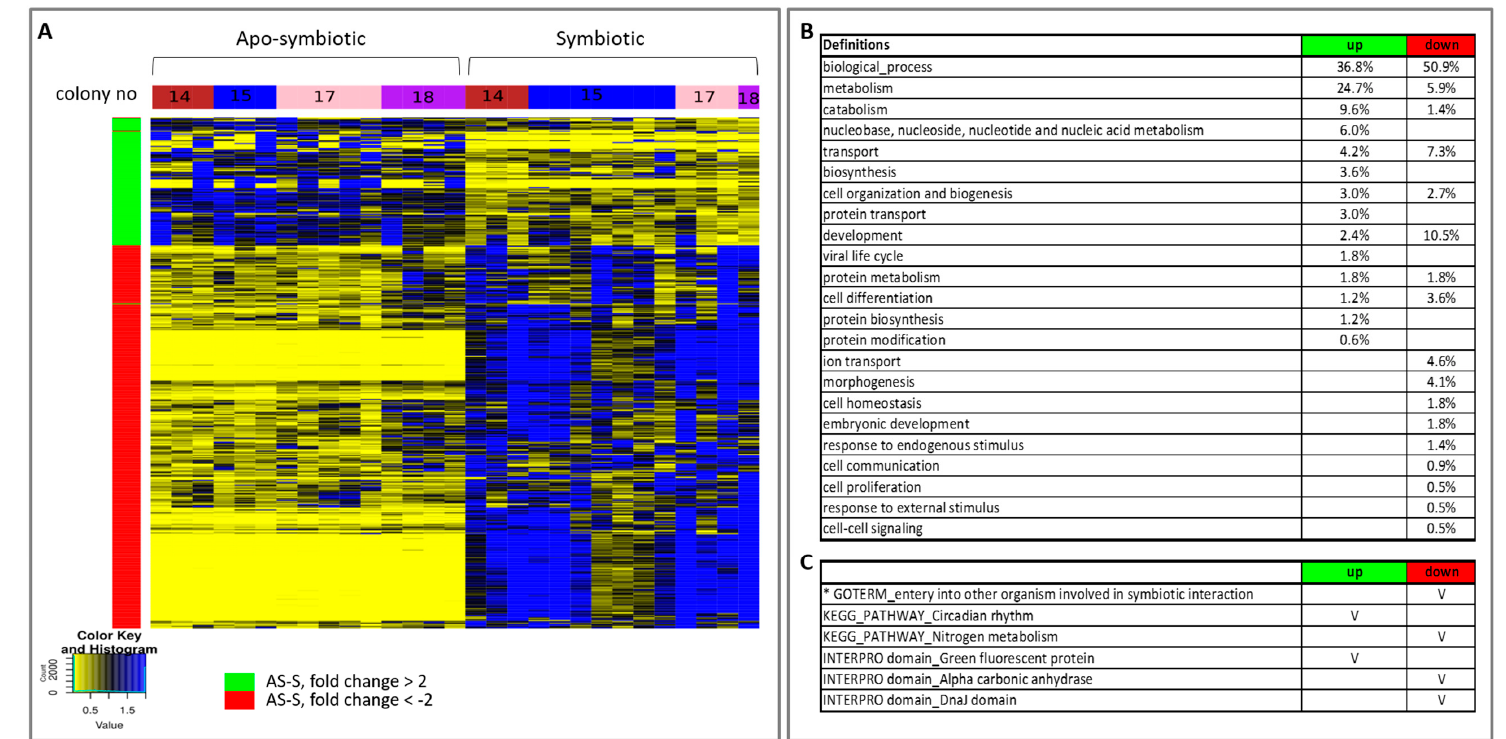
Figure 5. Heat map of hierarchical clustering and enrichment analysis of all apo ‐ symbiotic vs all symbiotic samples. ( A ) A heat map showing the relative transcript abundance levels of differentially expressed genes ( p value <0.05) having a mean fold change of > 2 or < − 2, between apo ‐ symbiotic samples and symbiotic samples. The tested groups, colonies 14, 15, 17 and 18, are marked in the horizontal colour bar: red, blue, pink and purple, respectively. ( B ) Enriched Gene Ontologies (GOs) in the up ‐ regulated and down ‐ regulated groups of apo ‐ symbiotic vs symbiotic analysis. GO slim terms, generated by the web ‐ based tool CateGOrizer [50], are presented as a percentage of the total GOs of the group. ( C ) Other GO, KEGG pathways, INTERPRO domains of interest that were significantly enriched in the up ‐ or down ‐ regulated groups are marked with V. An asterisk marks a result from a reciprocal BLAST analysis.